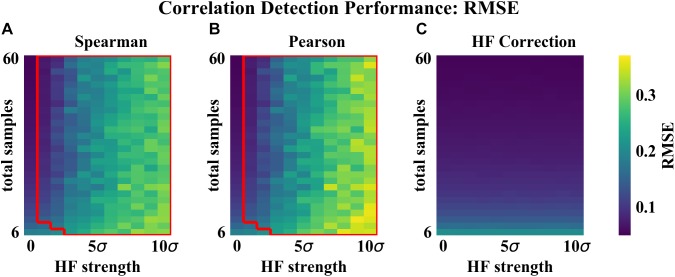
Correlation detection performance for simulated data: correlation matrix RMSE. Heat map colors represent the mean correlation matrix RMSE based on 50 simulated data sets for each combination of HF strength and sample size. (A) Spearman correlations. (B) Pearson correlations. (C) HF correction. Red box in (A,B) indicates the set of conditions (HF strength and sample size) for which there was a statistically significant improvement for HF correction compared to the other method tested.